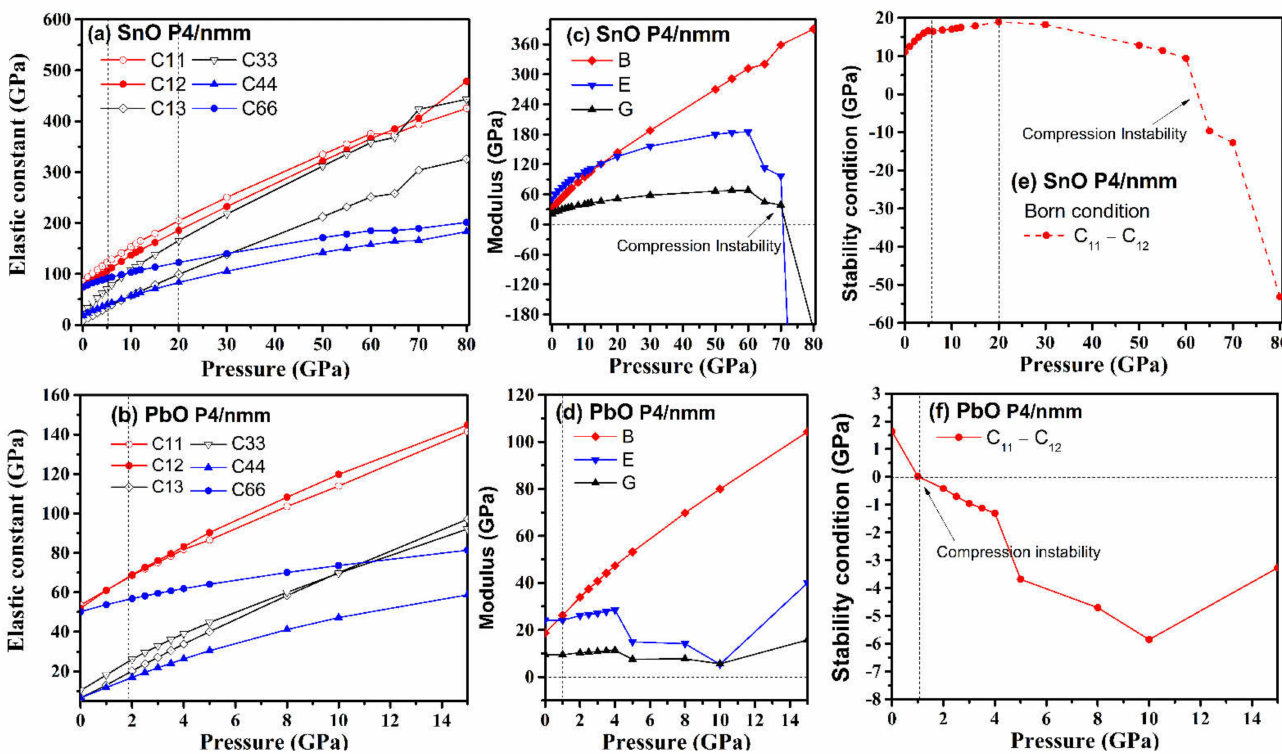
Figure 11. Comparison of P4/nmm SnO/PbO elastic properties upon compression: ( a , b ) elastic constants C ij ; ( c , d ) bulk (B), Young (E), and shear (G) modulus; ( e , f ) validation of the Born criterion: C 11 –C 12 >